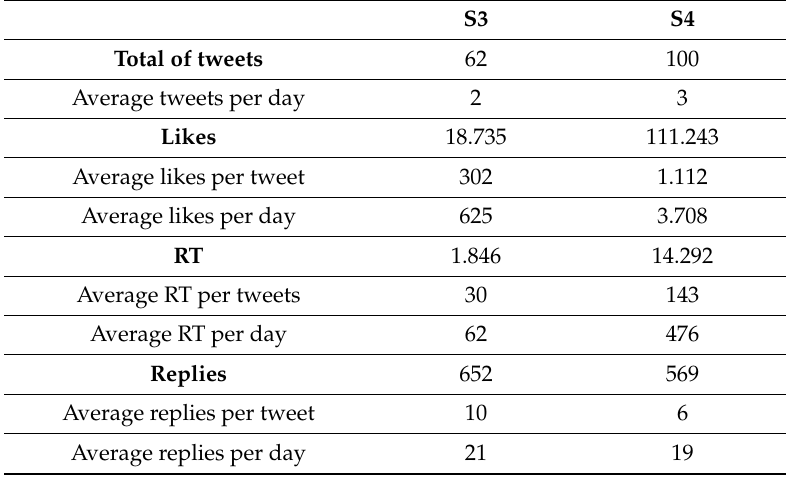
Table 2. Summary of the results of content analysis of Money Heist’s Twitter